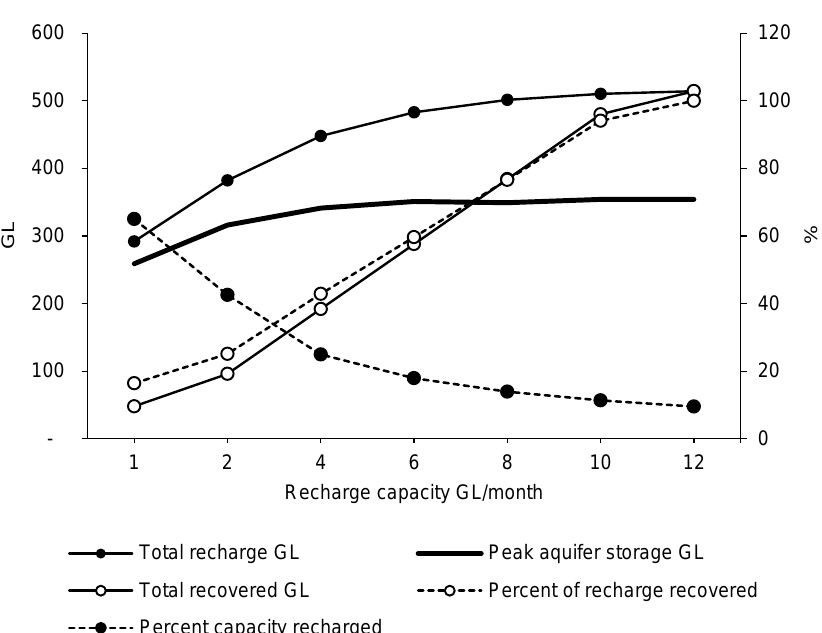
Figure 8. Results of simulations over 1965–2020 for different water banking capacities for the Macquarie River near Dubbo, showing total accumulated recharge and peak storage in the water bank (GL = 10 6 m 3 ).